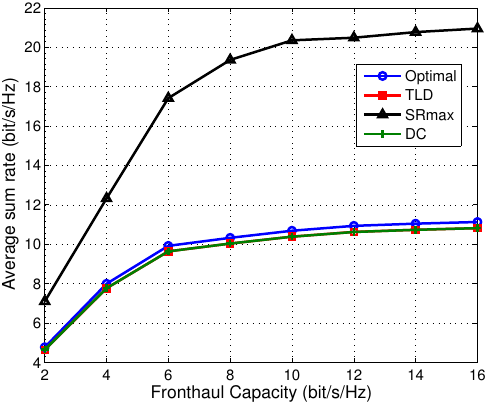
Figure 4. Average sum rate at various fronthaul